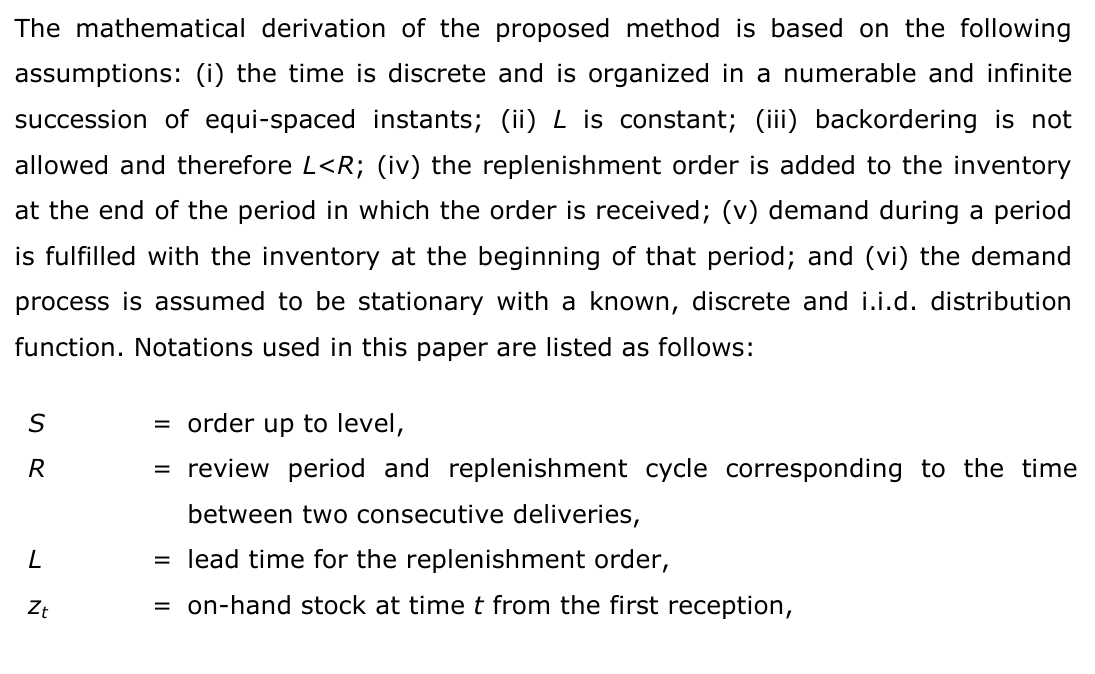
Figure 1. “Example of the stock evolution in a periodic review